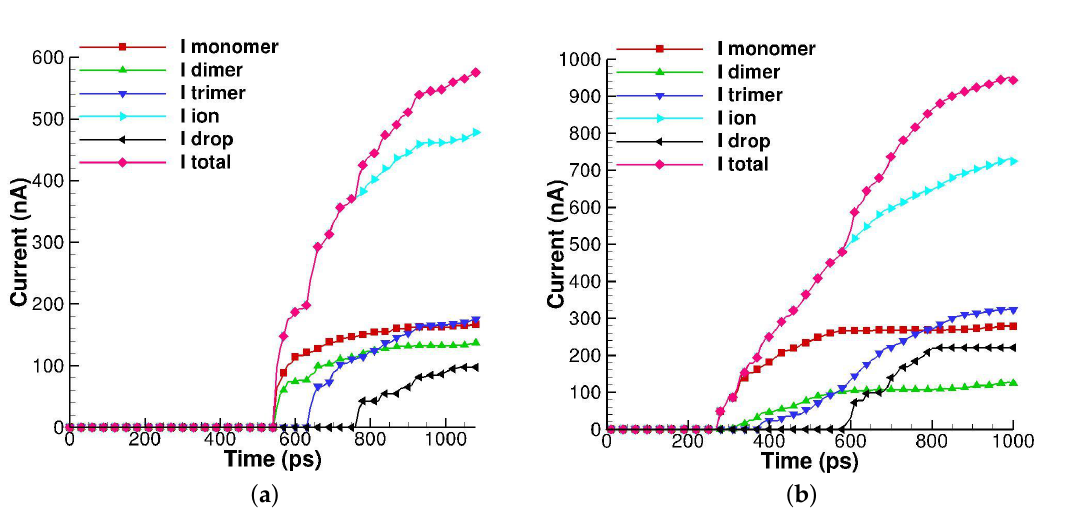
Figure 11. Comparison of ion species current sampled at the extractor plane as a function of simulation time. Mass flow rate of 1.22 × 10 − 12 and 1.14 × 10 − 11 kg/s for EMIM-BF 4 and EAN, respectively. The extraction voltages used are φ = − 17 and − 60 V for EMIM-BF 4 and EAN, respectively. ( a ) Coarse-grained (DC) MD EMIM-BF 4 simulation; ( b ) Coarse-grained (DC) MD EAN